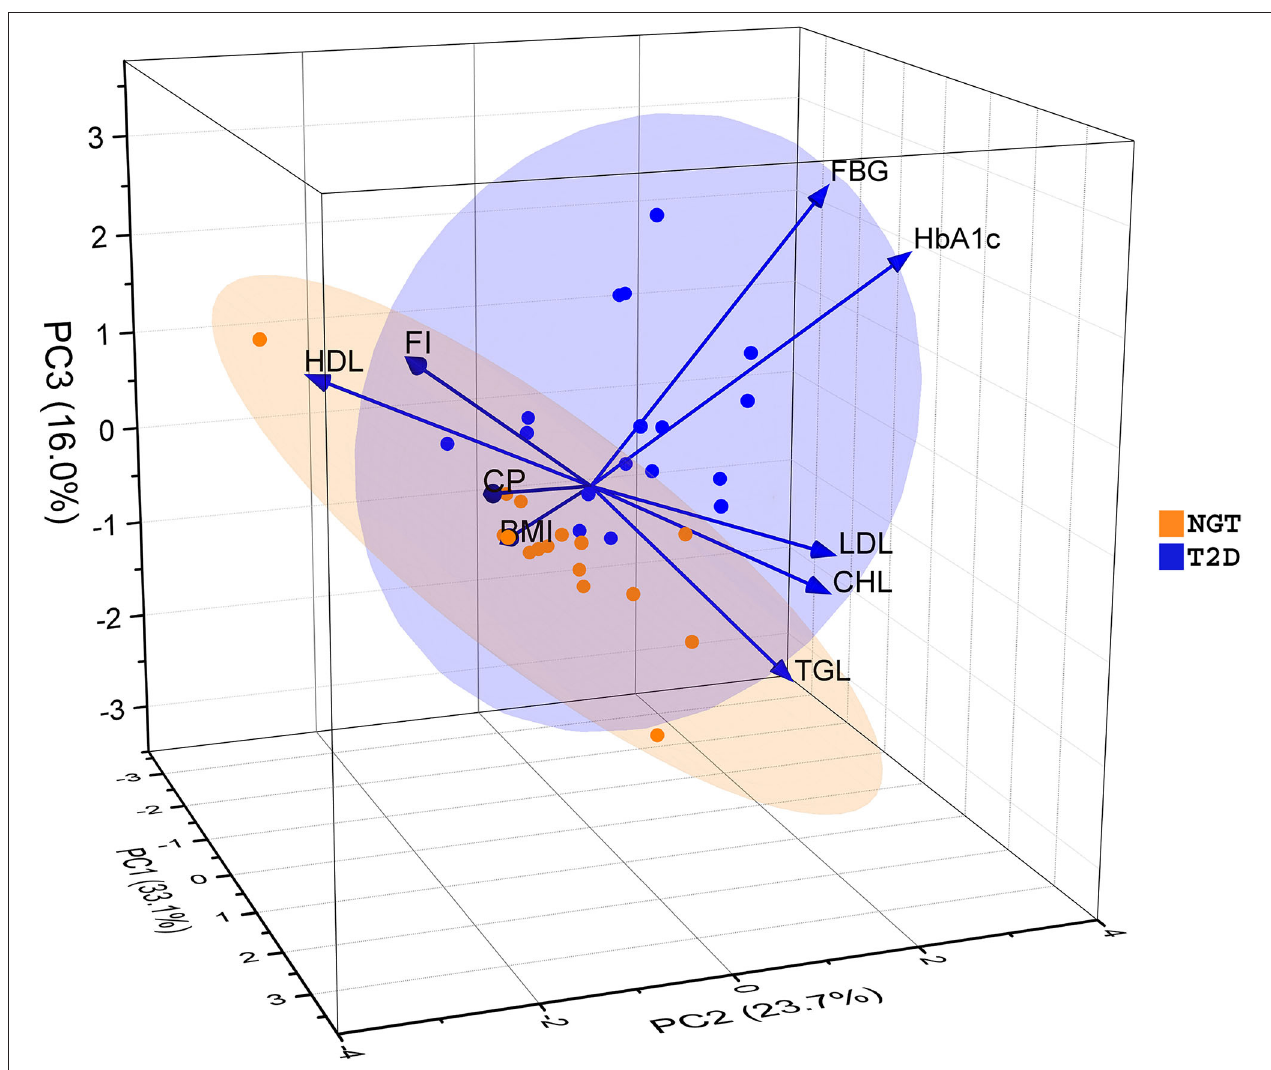
FIGURE 1 | Principal Component Analysis (PCA) based on physiological parameters of the Indian diabetes subjects and controls. The samples were divided into two groups along with three principal components (PCs). PC1, PC2, and PC3 explained 33.1, 23.7, and 16 percent of the total variation respectively. Here BMI, Body